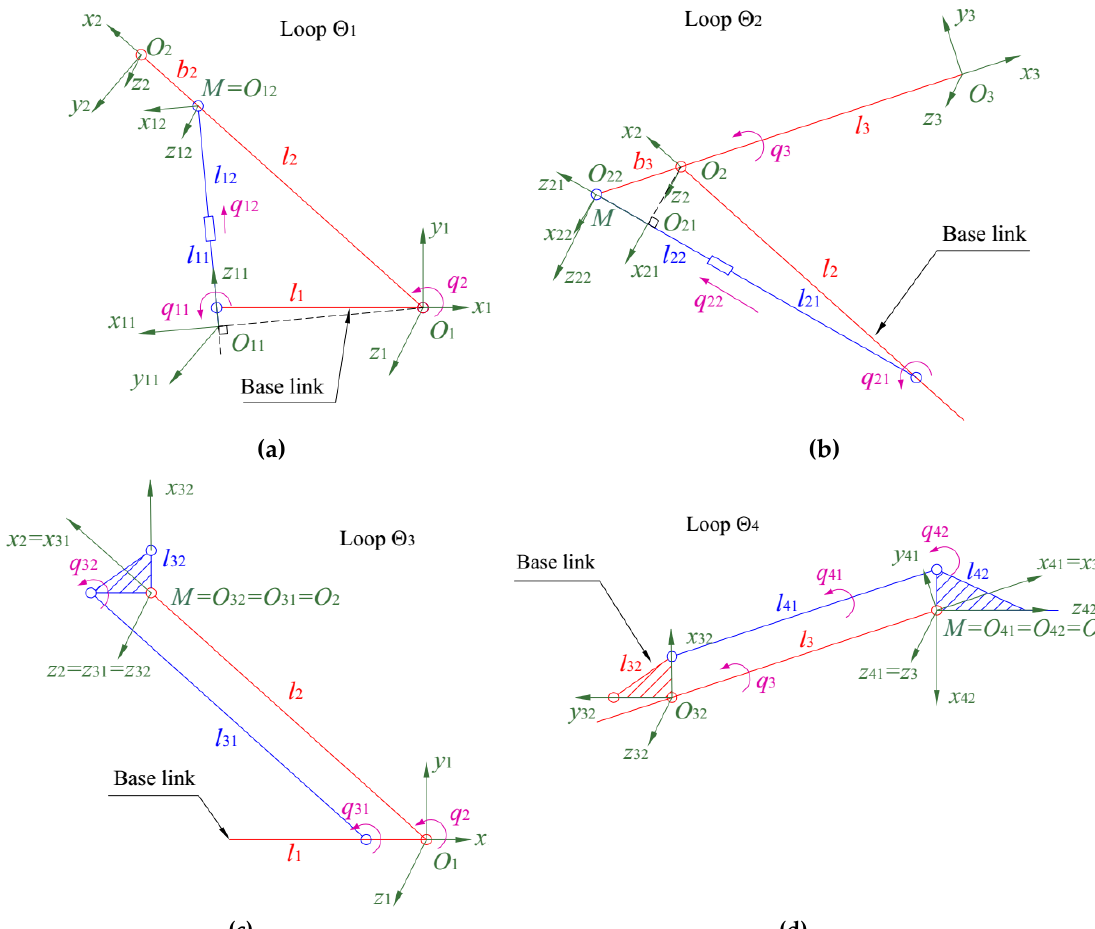
Figure 7. The local closed-loop linkages of the forging robot: ( a ) Loop Θ 1 ,( b ) Loop Θ 2 , ( c ) Loop Θ 3 , and ( d ) Loop Θ 4 . Table 1. The D-H notations of the four local closed loops.